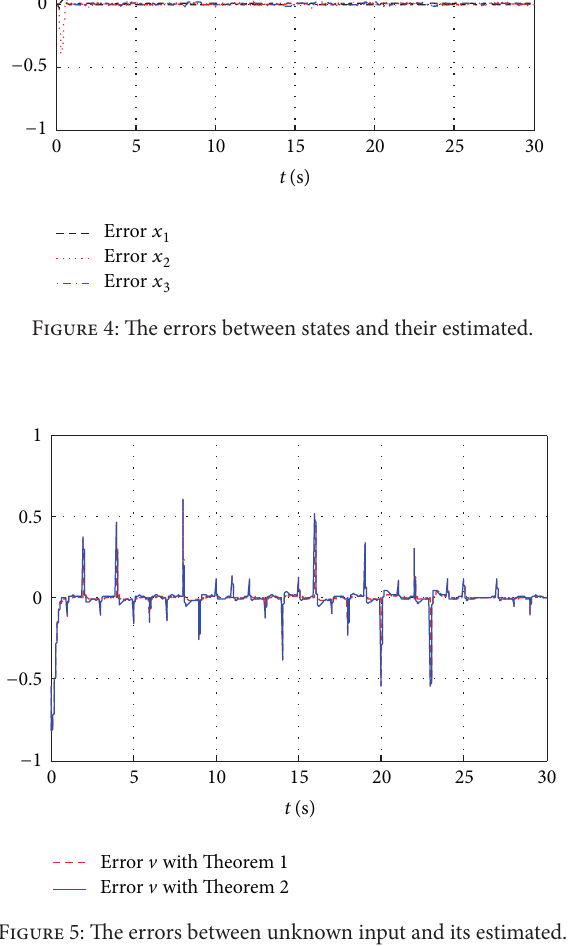
Figure 5: The errors between unknown input and its estimated.